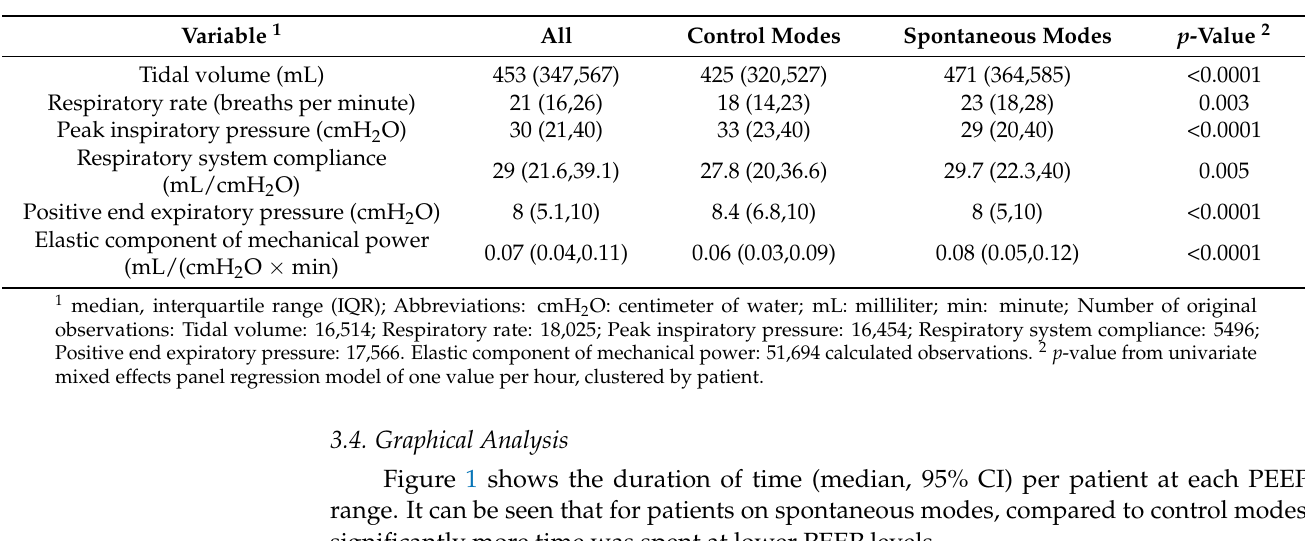
Table 2. Subset analysis of ventilator parameters during the transition from control to support modes, among patients with lung compliance <30 cmH 2